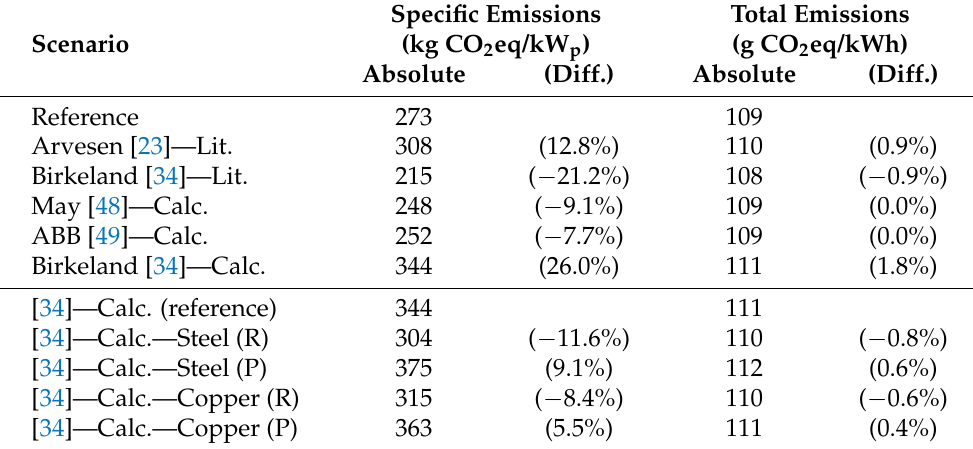
Table A3. Specific and total emissions for the cable scenarios (absolute values and relative difference as compared to the reference scenario). The top half of the table represents the scenarios created by using different cable models. The bottom half of the table represents the scenarios created by varying the source of material in Birkeland’s [34] model. (P) stands for primary material, (R) for recycled